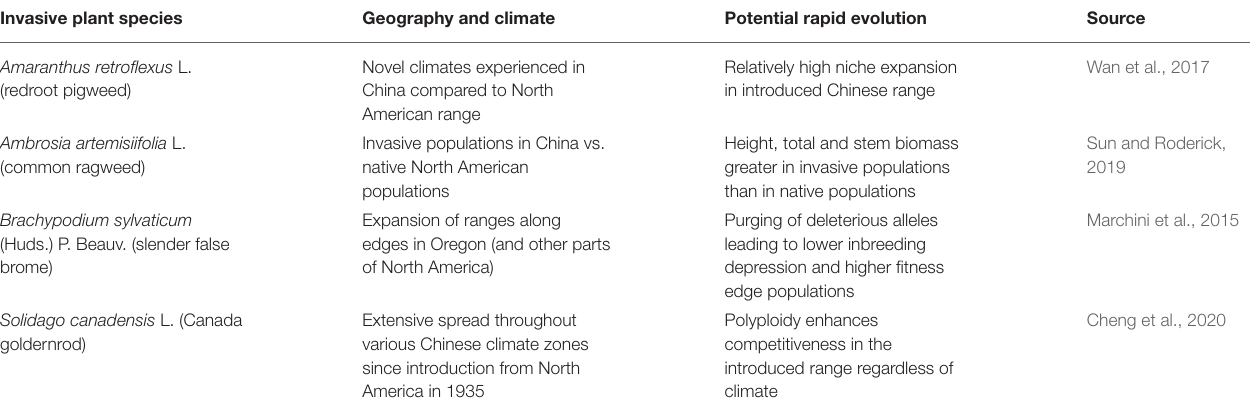
TABLE 1 | Cases demonstrating potential rapid evolution of invasive plants under climate change for species exhibiting general niche expansion in the invaded